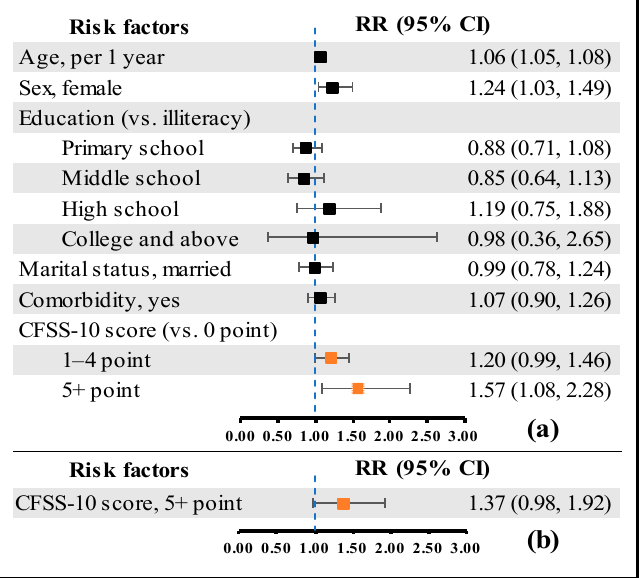
Figure 3. The risk ratios of one-year disability by different cut-off points of the CFSS-10. Model ( a ) and model ( b ) were both adjustment for age, sex, education, marital status and comorbidity. RR: risk ratio; CI: confidence interval; CFSS: Chinese frailty screening scale. Table 5. The results of the CFSS-10 predicting one-year disability and all-cause mortality (sample 2).